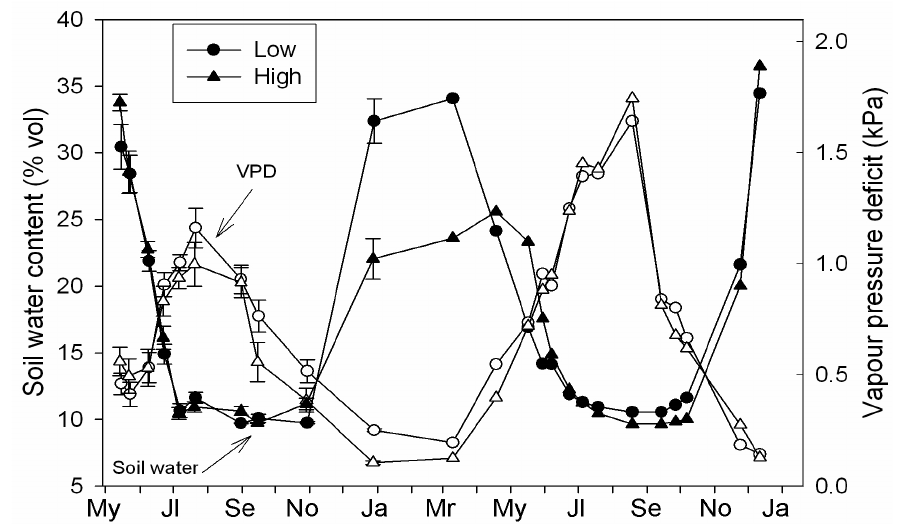
Figure 2. Vapour pressure deficit (VPD) and soil water content measured in two Abies pinsapo populations along an altitudinal gradient (low elevation, 1200 m; high elevation, 1550 m). Measurements were taken during two consecutive growing periods. Errors bars represent the standard error; significant differences between stands were tested using repeated measures MANOVA (VPD n = 4 data loggers per elevation; soil water content n = 10 sampling points per